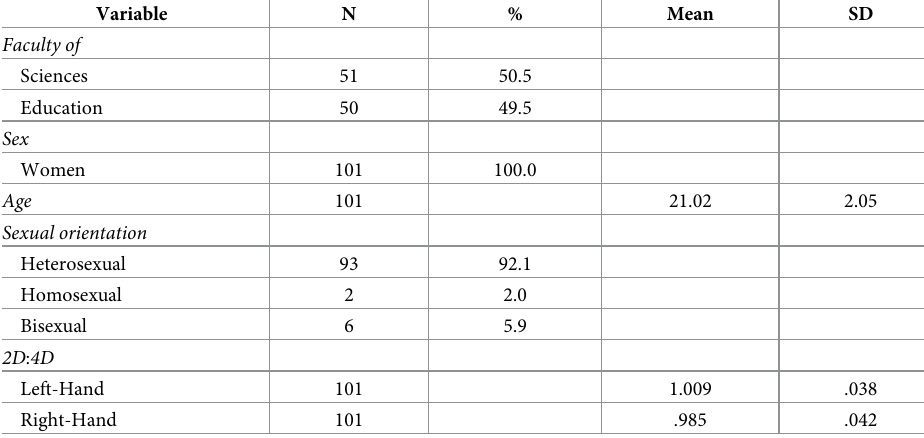
Table 1. Characteristics of the